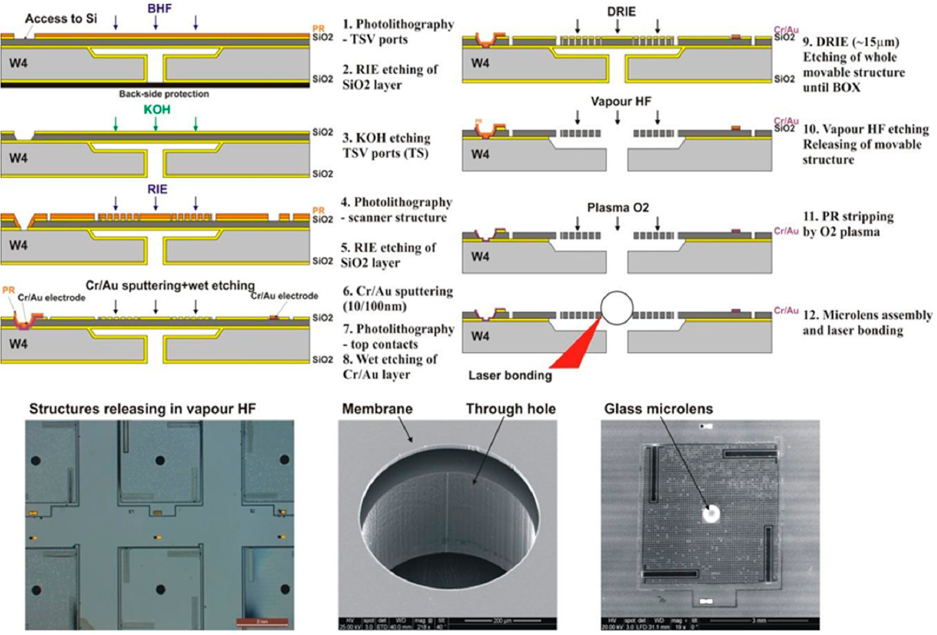
Figure 16. Flow chart of technological process of